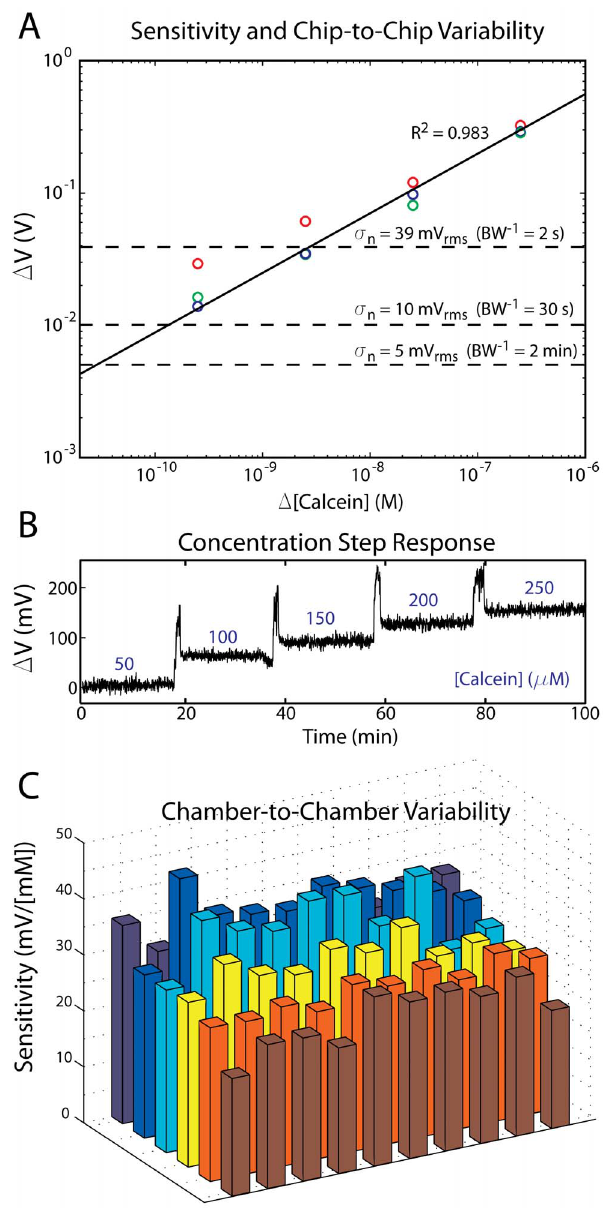
Figure 3. Fluorescence sensitivity and linearity. (A) Different concentrations of calcein were introduced into a microfluidic cartridge and the corresponding change in photoamplifier voltage was recorded. The circles indicate the mean signal amplitude across all reaction wells for three different chips (red, green, and blue). As expected, the relationship between calcein concentration and photoamplifier output is linear (R 2 =0.983). Limit of detection can be evaluated by determining when this trend line crosses the noise floor of the instrument at a given bandwidth. At a time resolution (BW 2 1 ) of 2 min, the m BAR can distinguish changes in calcein concentration of 30 pM, which is orders of magnitude below the fluorophore concentrations typically used in nucleic acid amplification reactions. (B) 50 m M steps of calcein are clearly visible in the photoamplifier output and this output remains stable for a constant concentration. (C) Due to the nature of the illumination scheme and the lack of optics, there is some nonuniformity of sensitivity across the 6 6 10 reaction chamber array. However, we take this into account and normalize each well by its mean sensitivity, shown here. In this graphic, the illumination LEDs and sample inlets are located above the topmost row.